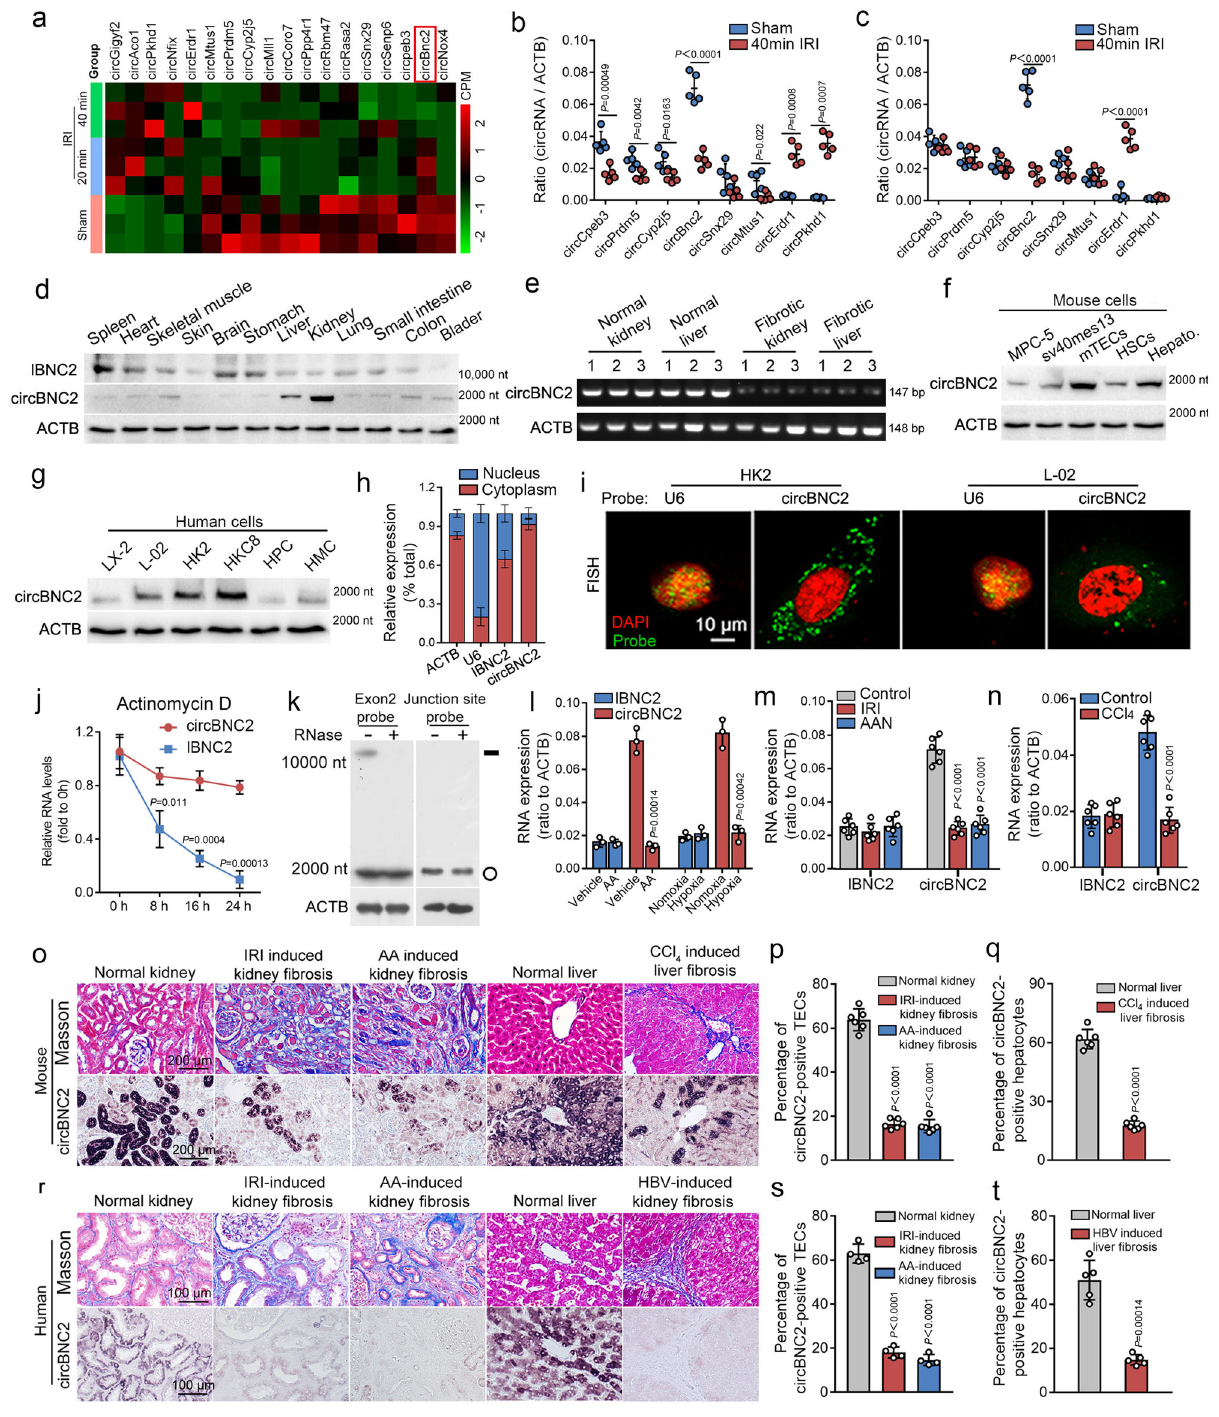
Supplementary Fig. 2, depleting BNC2 protein had no effect on the cell cycle (Supplementary Fig. 2r –